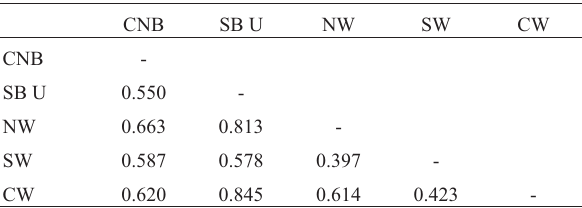
Table 2 - Pairwise (cid:5) ST values between defined geographical populations for L. colocola.